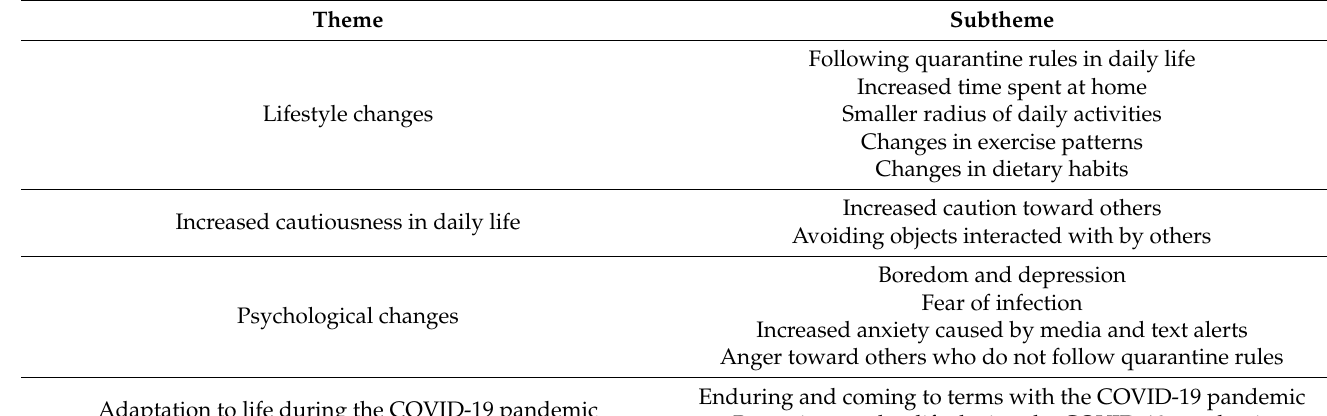
Table 2. Outcome of qualitative